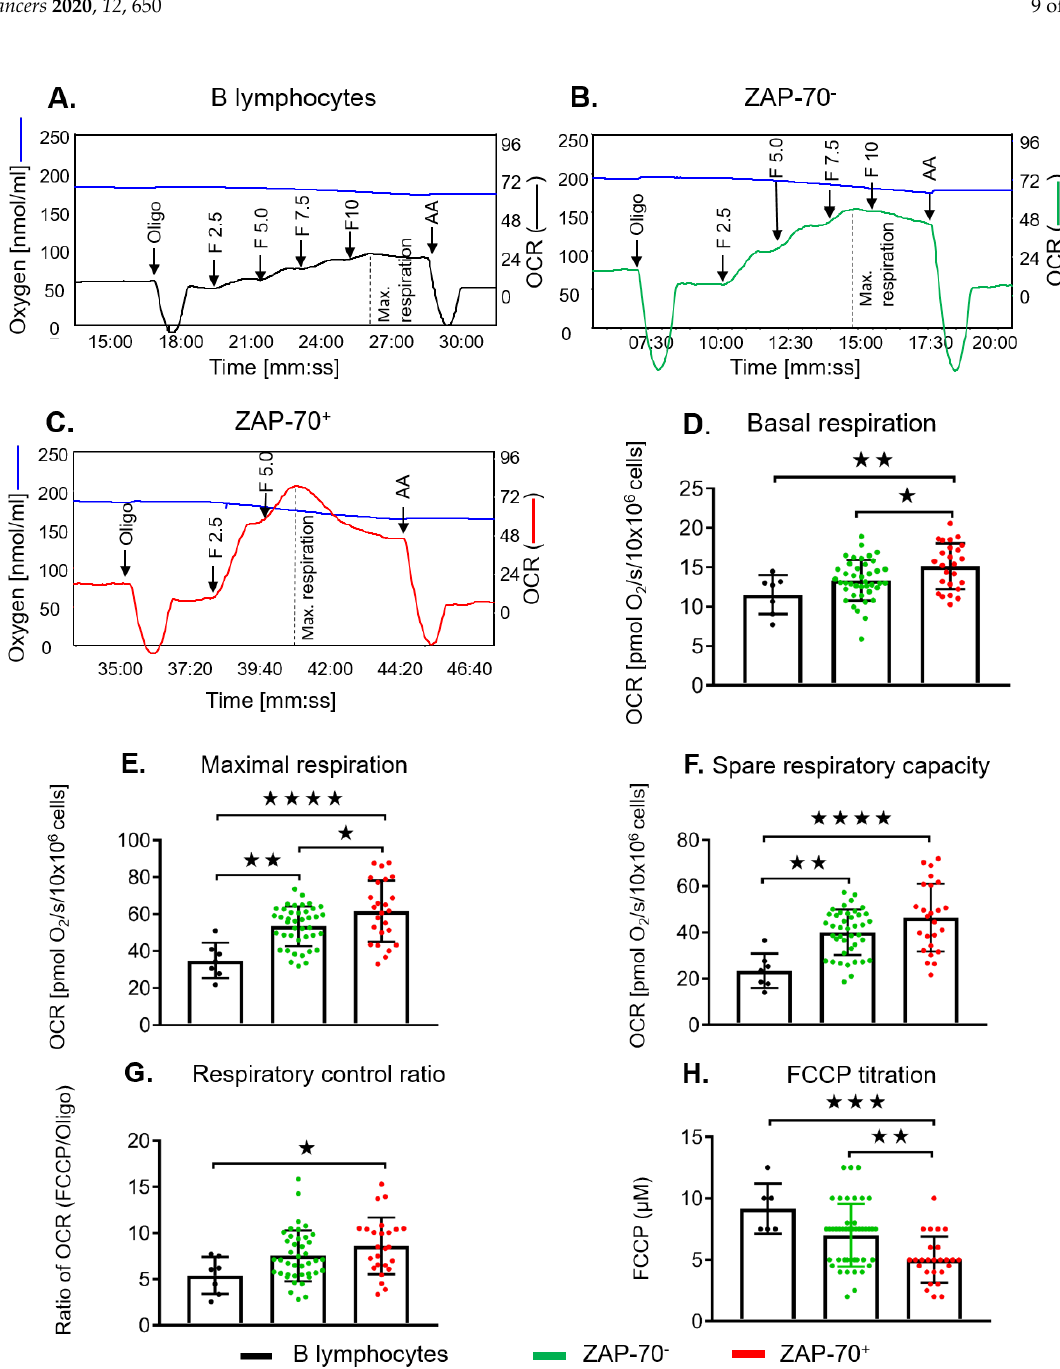
Figure 4. Baseline mitochondrial bioenergetic profiles in B lymphocytes and the influence of ZAP-70 on these profiles in CLL cells. The representative measurements of mitochondrial respiration rates by the Oroboros oxygraph are depicted in B lymphocytes ( A ), ZAP-70 − ( B ), and ZAP-70 + ( C ) CLL cells with subsequent additions of oligomycin (oligo, 2 µ M), FCCP (F2.5–10, 2.5–10 µ M), and antimycin A (AA, 2 µ M). Blue line indicates the level of oxygen (nmol / mL, left Y-axis) and oxygen consumption rates, OCR (pmol O 2 / s / 10 × 10 6 cells, right Y-axis) in B-lymphocytes (black line), ZAP-70 − (green), and ZAP-70 + (red) CLL cells. Basal respiration ( D ), maximal respiration ( E ), the spare respiratory capacity ( F ), and the respiratory control ratio ( G ) are summarized in B lymphocytes (black circles, N = 7), ZAP-70 − (green circles, N = 41), and ZAP-70 + (red circles, N = 25), respectively. The titrations of FCCP in B lymphocytes, ZAP-70 − , and ZAP-70 + CLL cells are shown ( H ). Values are the mean ± S.D., * p < 0.05, ** p < 0.01, and **** p < 0.0005 (one-way ANOVA with Tukey’s post hoc test).